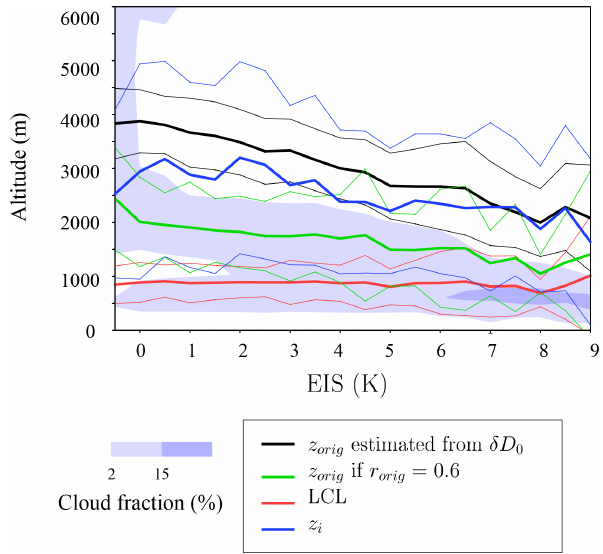
Figure 12. Composites as a function of EIS of seasonal mean of z orig (black), z orig (r orig = 0 . 6 ) (green), z i (blue), and LCL (red). The composite profiles of cloud cover are also shown, showing deep clouds when EIS is close to 0 and the shallowest clouds when EIS is largest.